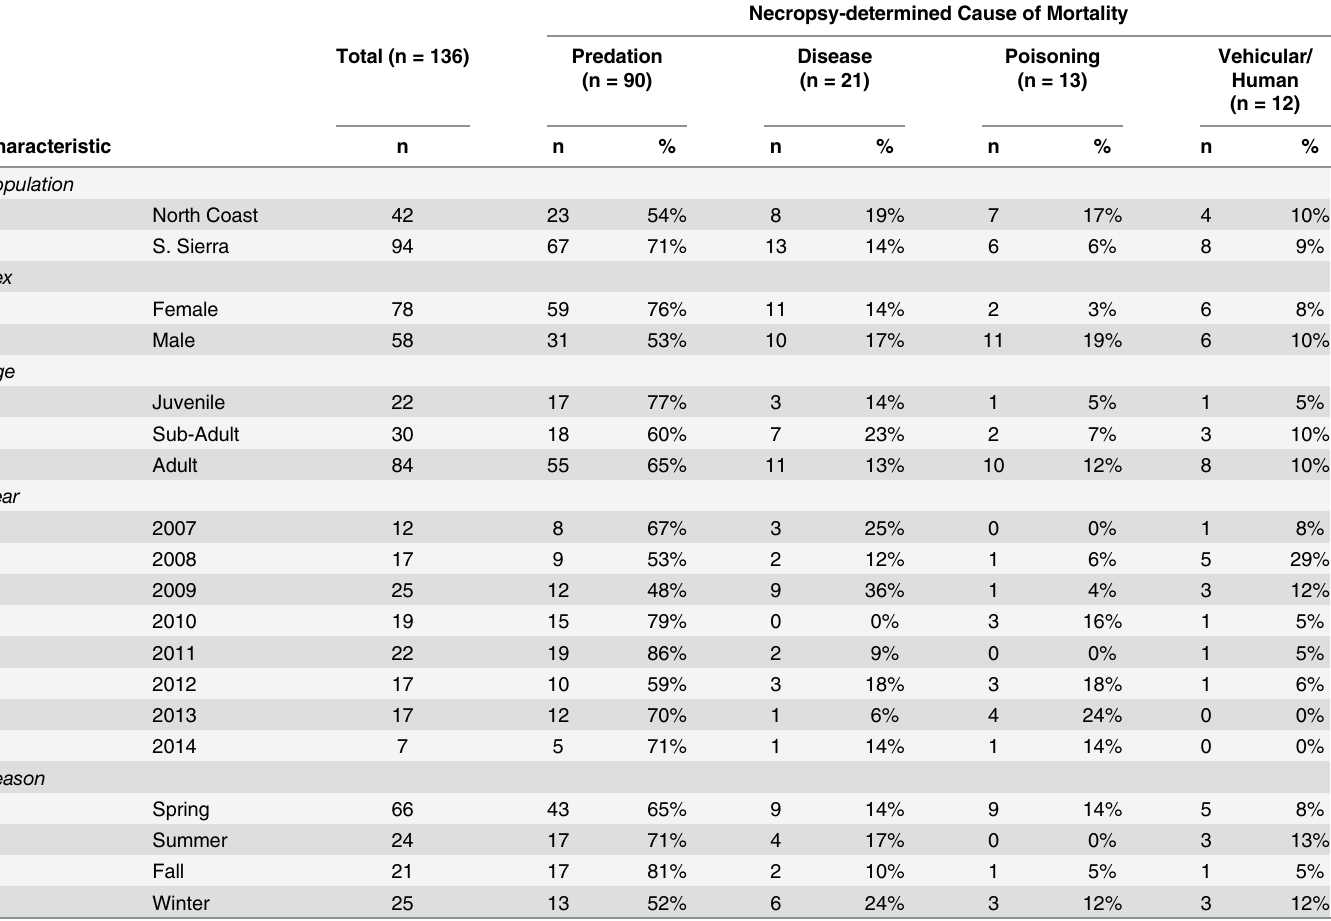
Table 2. Necropsy-determined cause-specific mortality frequencies for fishers ( Pekania pennanti ) by sex, age, year and season from fisher popu- lations in northern California and southern Sierra Nevada. Data were combined from 2007 to 2014 (n = 136). These data include 7 uncollared fishers dis- covered opportunistically dead due to vehicle strike so relative frequency of vehicle-related deaths may be